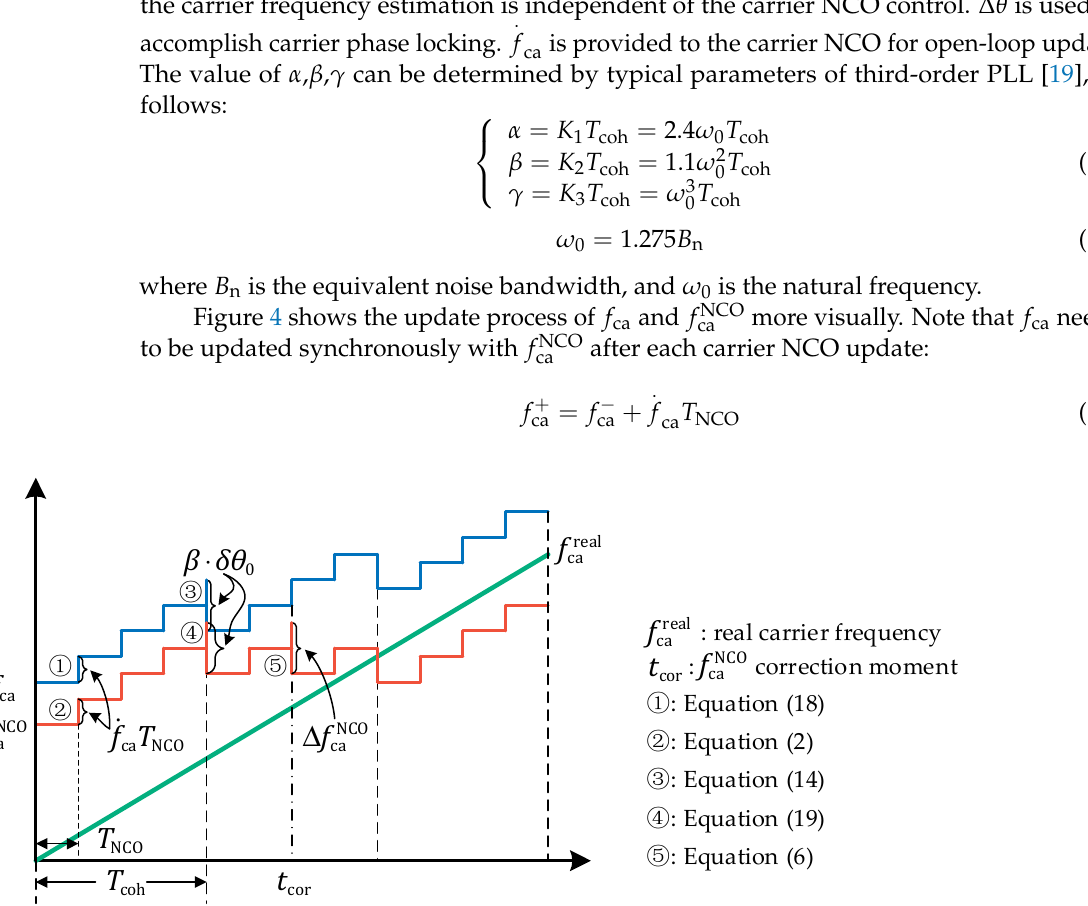
Figure 4. Diagram of the update process of f ca and f NCO ca . (For more clearly, a coherent integration time contains four carrier NCO update periods.).